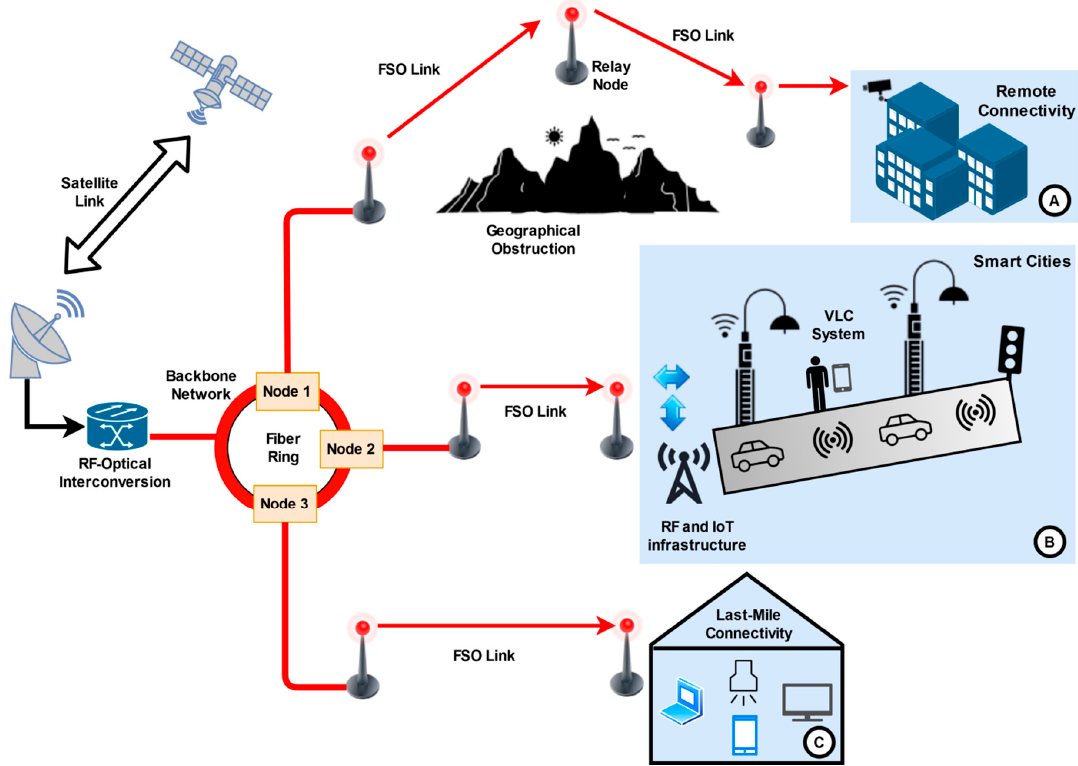
Figure 2. Smart city plan with optical connectivity to end-users.